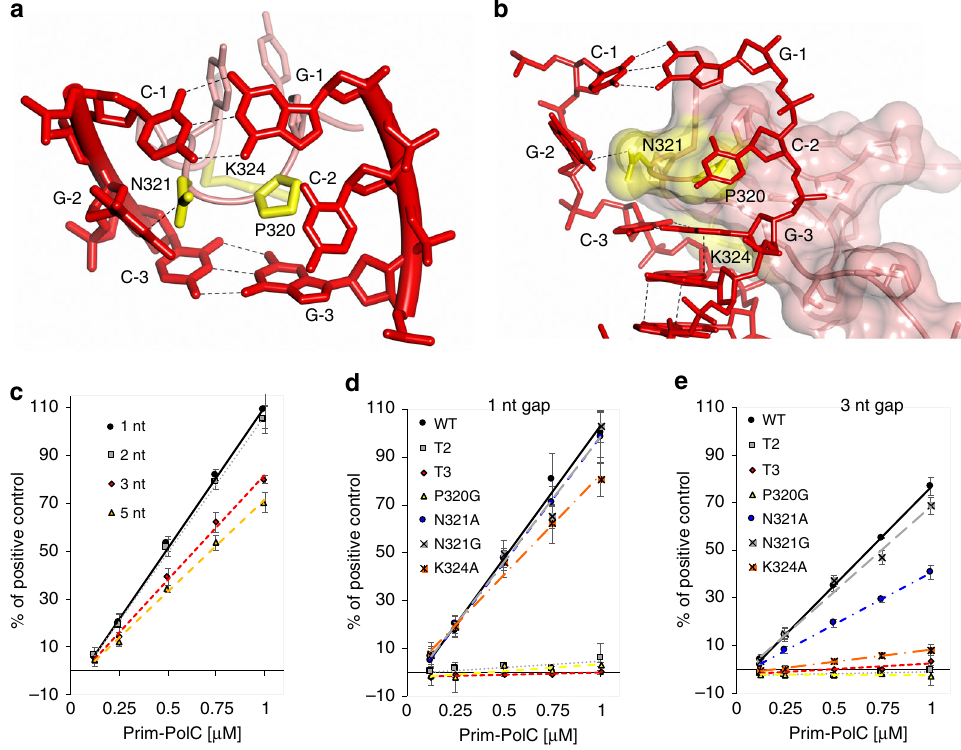
Fig. 3 Loop 3 interactions with DNA are requisite for gap fi lling. a , b Schematic solvent-accessible surface representations of Loop 3 interacting with template strand DNA, shown in two orientations. Residues that interact are highlighted in yellow, and hydrogen bonds are depicted in black (hatched line). See also Supplementary Fig. 2b and c. c Flipping activity of Prim – PolC on different short-gap substrates examined using a 2-aminopurine (2-AP)-based assay. The ability of Prim – PolC to fl ip the − 2 primer base (2-AP) was measured as an increase in 2-AP fl uorescence intensity when the − 2 base was unpaired. Each reaction contained 0, 0.125, 0.5, 0.75 or 1 µ M Prim – PolC (WT), 1 µ M substrate, 5 mM Ca 2 + ions and 250 µ M ATP. d , e Flipping activity of Prim – PolC variants. Quanti fi cation of primer − 2 base fl ipping by Prim – PolC variants on 1-nt ( d ) or 3-nt gap ( e ) substrates under the same conditions as stated in ( c ). Data shown ( c , d and e ) are representative of the mean of at least three individual experiments, and error bars show the standard